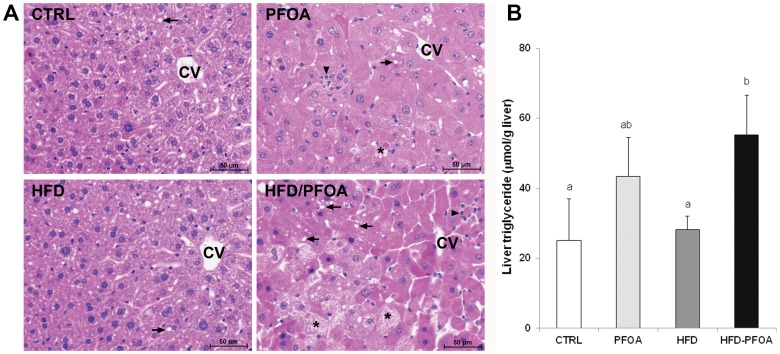
Histopathological alterations and triglyceride accumulation in the liver of mice fed HFD or/and PFOA.Adult mice were pair-fed a high-fat diet (HFD) or low fat control diet (CTRL) with or without perfluorooctanoic acid (PFOA) administration at 5 mg/kg/day for 3 weeks. A. Liver histopathology (H&E staining). Arrows: Lipid droplets. Arrowhead: Inflammatory cell infiltration. Asterisks: Necrosis. CV: Central vein. B. Liver triglyceride contents. Data are means ± SD (n = 7–8). Significant differences (p<0.05) between a and b were determined by One-Way ANOVA with Dunnett’s post hoc comparison.